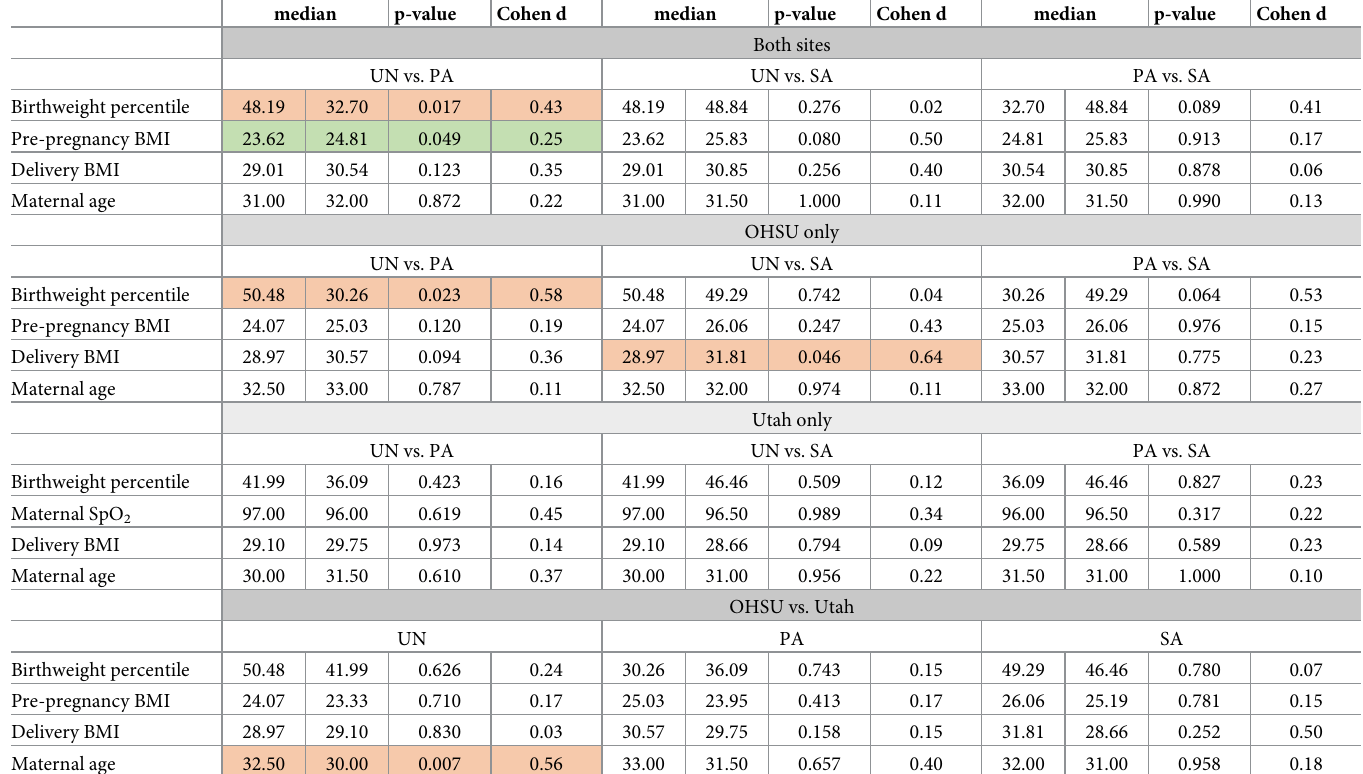
Table 3. Physiological variables, with p-values and effect sizes (Cohen’s d), for study subjects stratified by category and site. Effect size is considered small (green cells) when p < = 0.05 and 0.2 < = d < 0.5, and medium (orange cells) when p < = 0.05 and 0.5 < = d < 0.8.